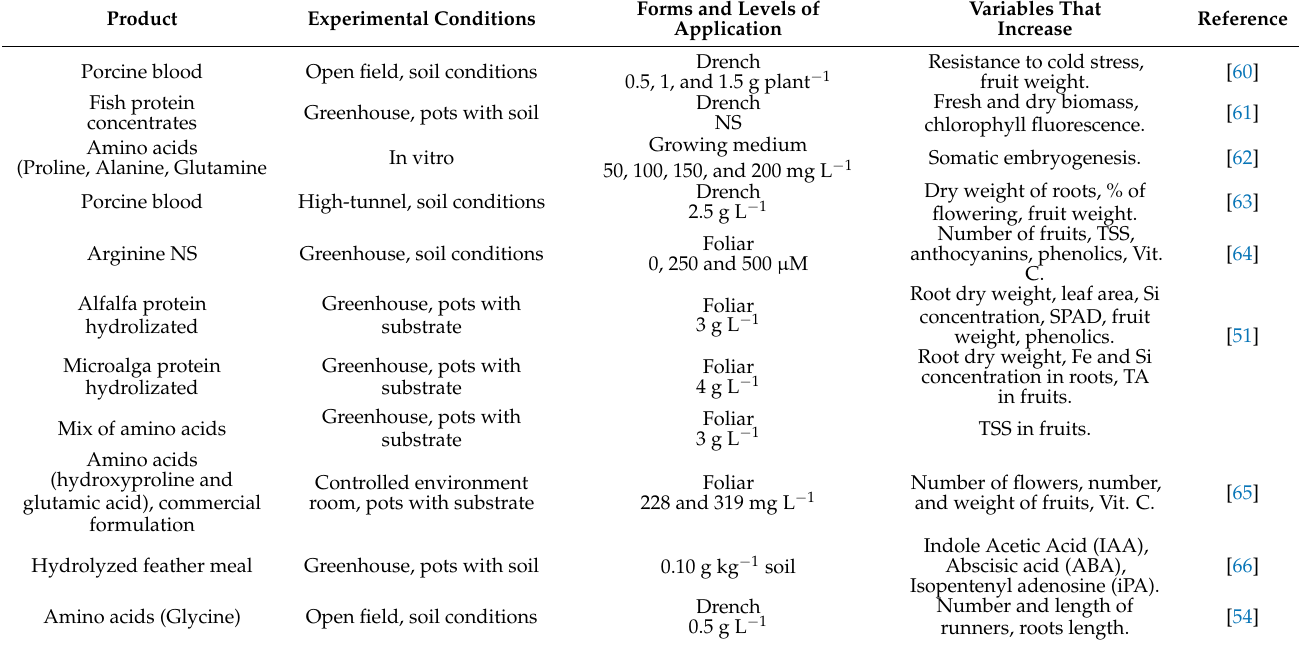
Table 2. Positive effects of protein hydrolysates on some growth or quality variables of strawberry